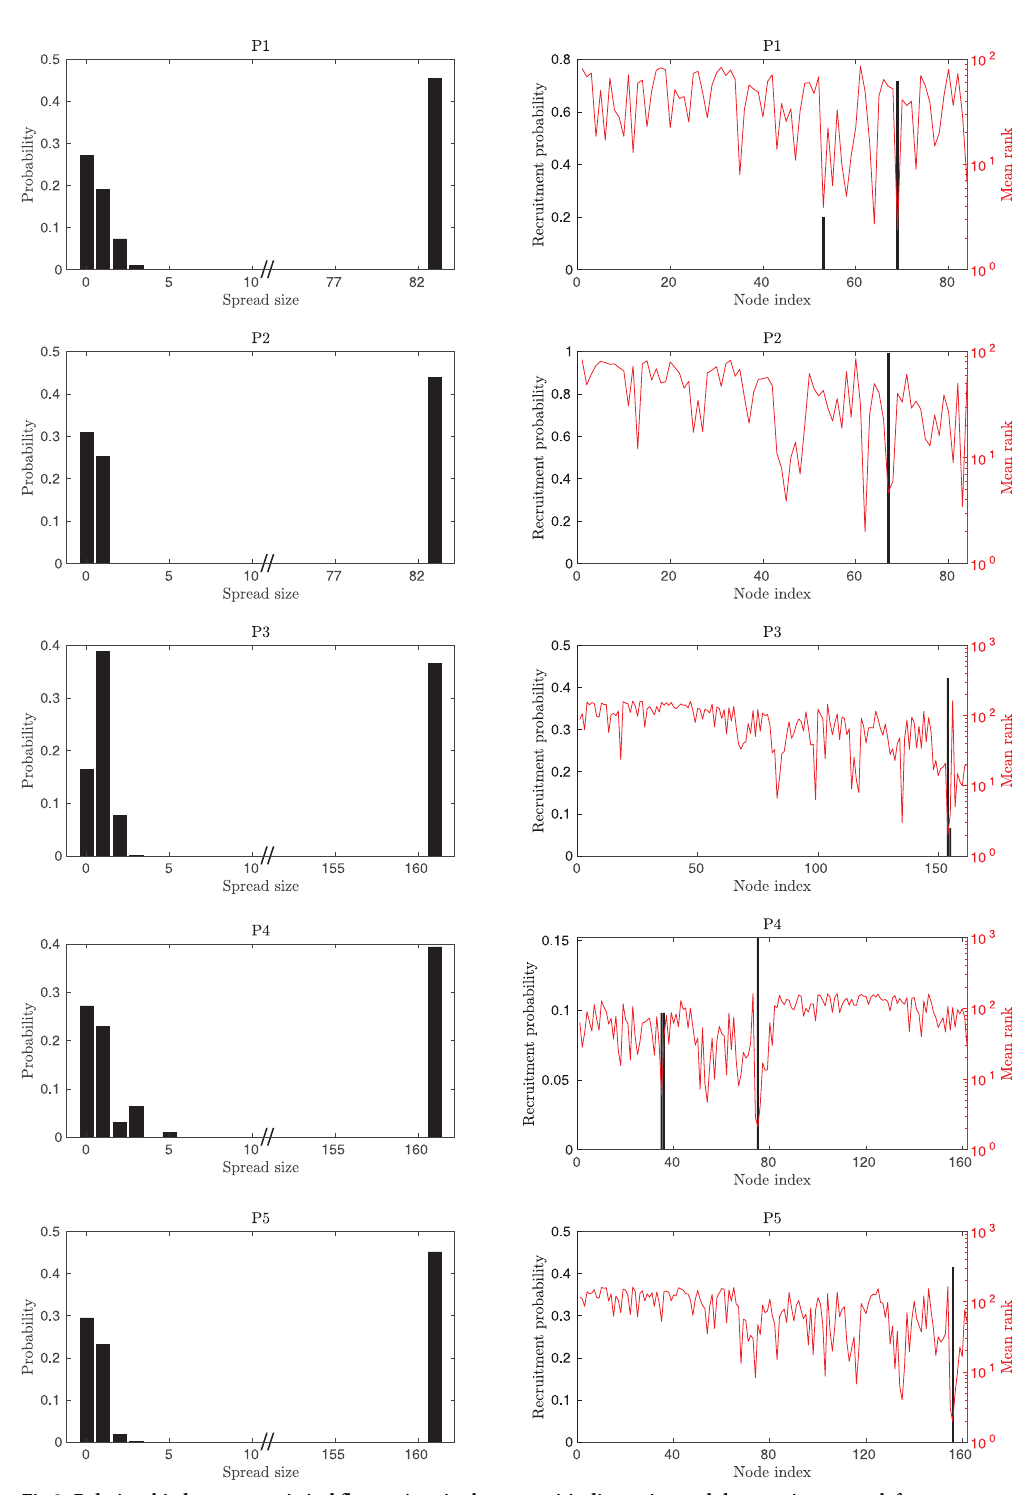
Fig 8. Relationship between statistical fluctuations in the near-criticality region and the recruitment rank for surrounding nodes based on linear stability analysis. Left column We examined the spread size (number of recruited surrounding nodes into the seizure; first column) when the epileptor network dynamics is in the near-criticality region (see Fig 2). Each row corresponds to a given patient-specific connectivity matrix. The empirical probability distributions show two clear modes of seizure spread in this region, one at small or no spread and the other at full network spread.